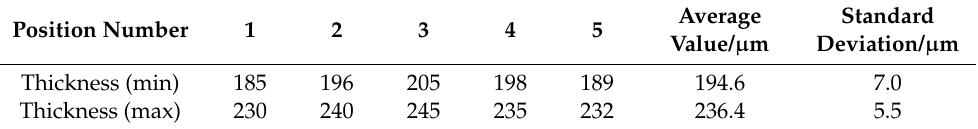
Figure 3. SEM image of coating cross-section (etched). Table 1. Coating thickness at different positions.